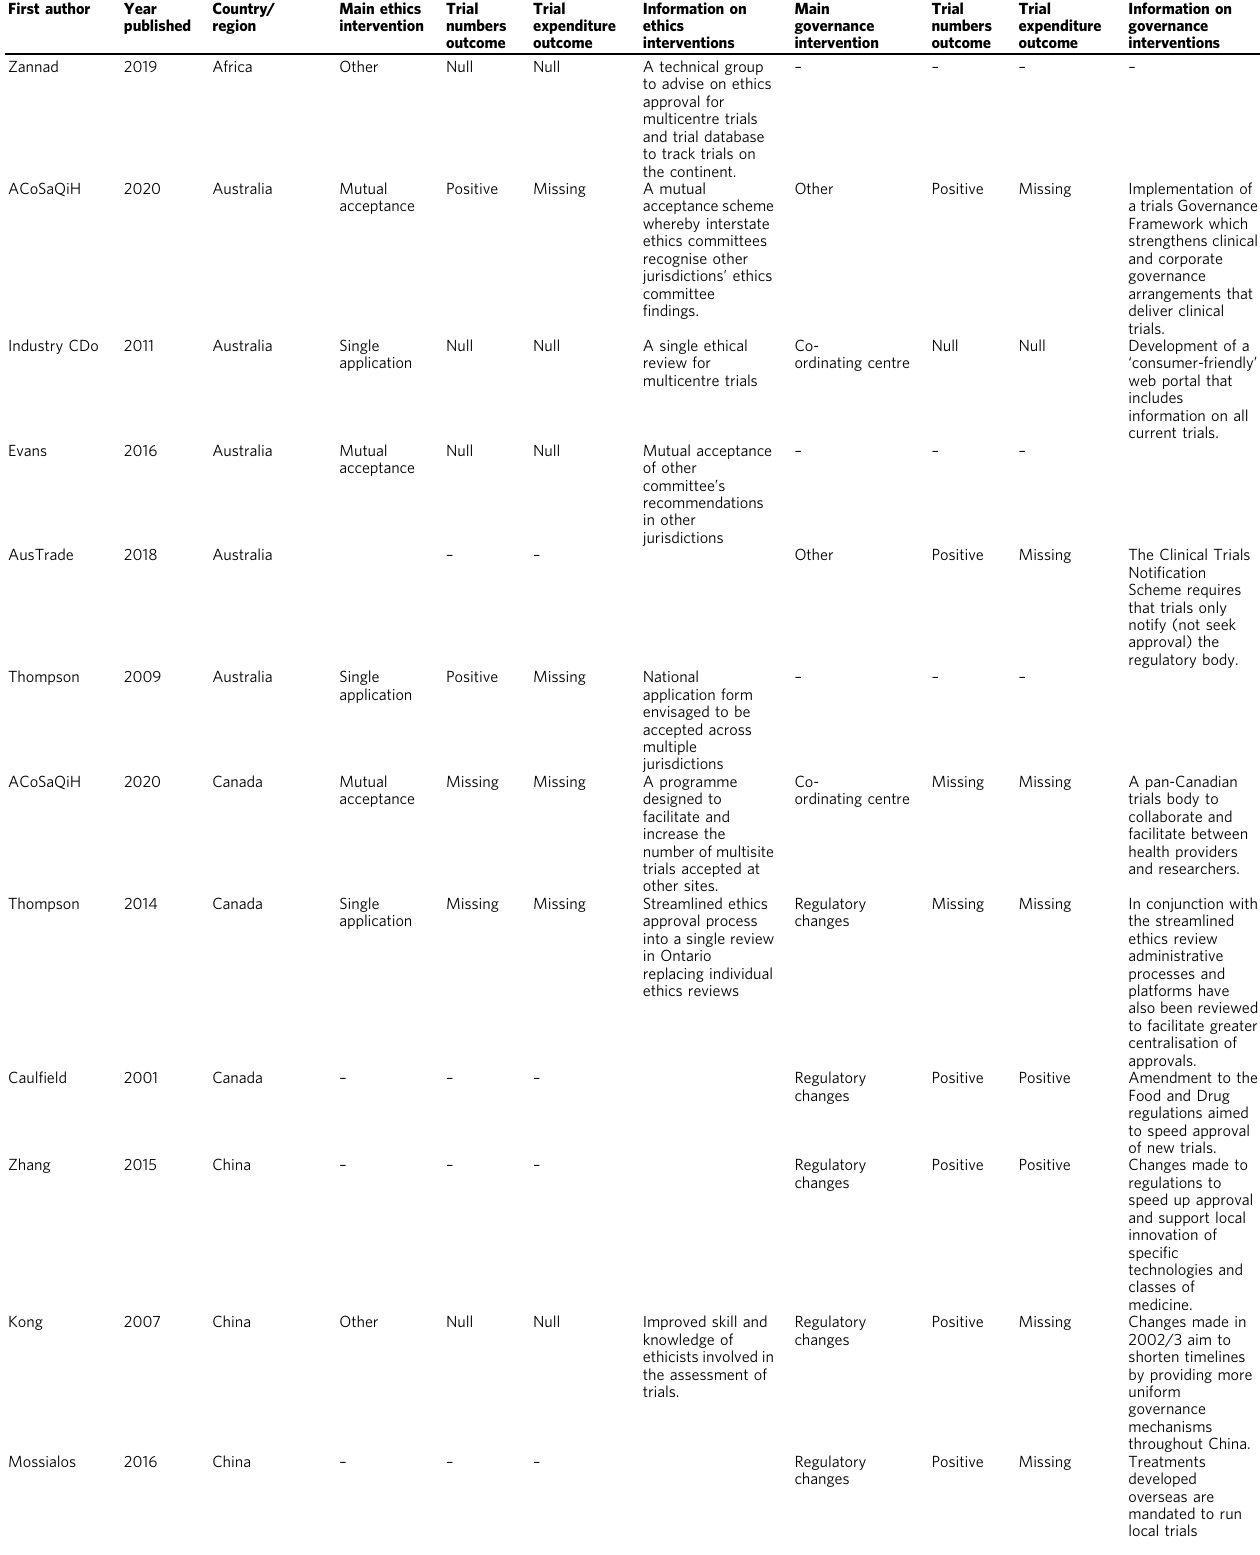
Table 2 Characteristics of studies describing jurisdictional